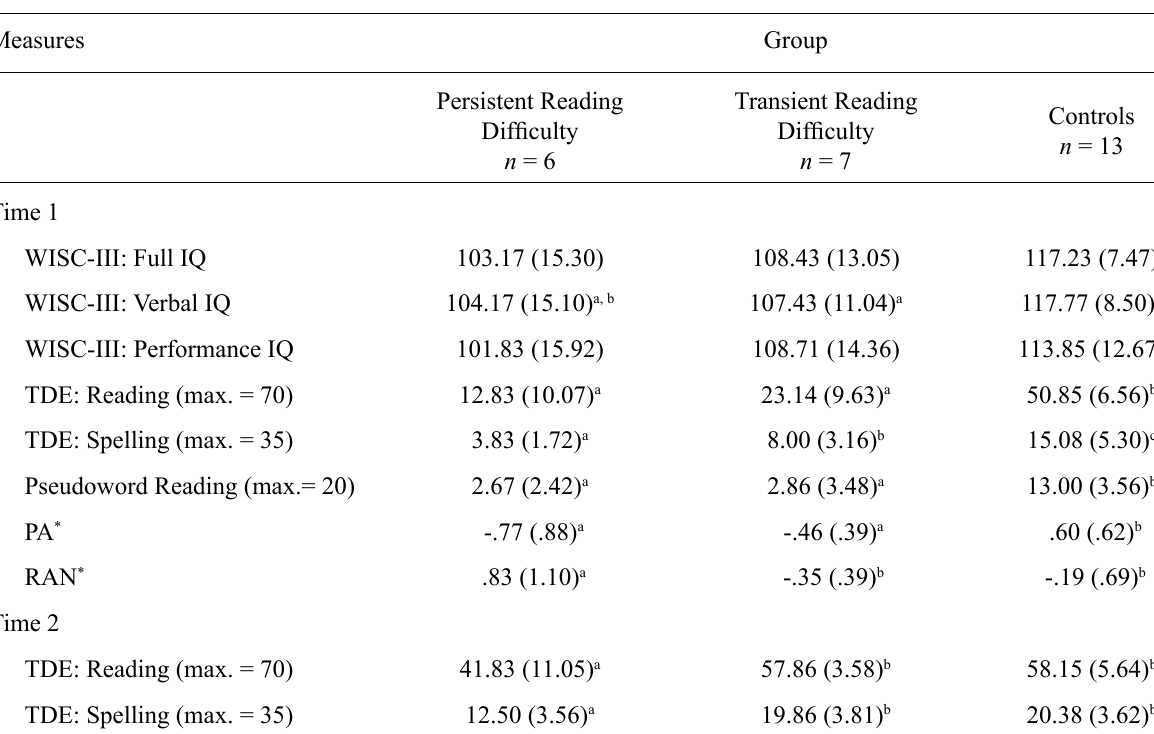
Mean Age and Mean Scores (and Standard Deviations) on the Literacy and Intelligence Tests, as a Function of Group and